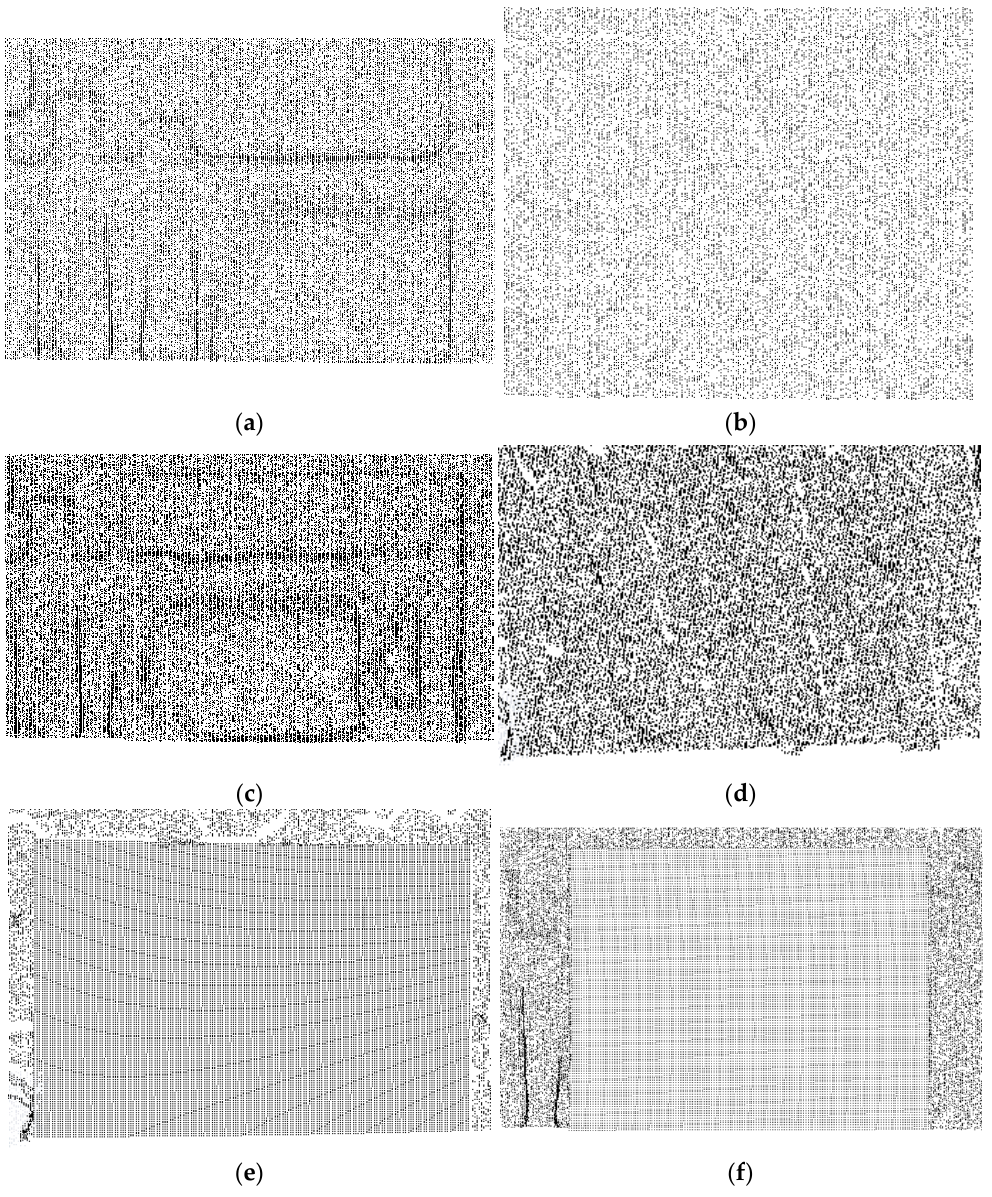
Figure 13. Filled results of artificial holes using different methods. ( a) Original point cloud of arti- ficial holes 1, ( b ) Original point cloud of artificial hole 2, ( c ) Filling artificial hole 1 by our method, ( d ) Filling artificial hole 2 by our method, ( e ) Filling artificial hole 1 by MLS, ( f ) Filling artificial